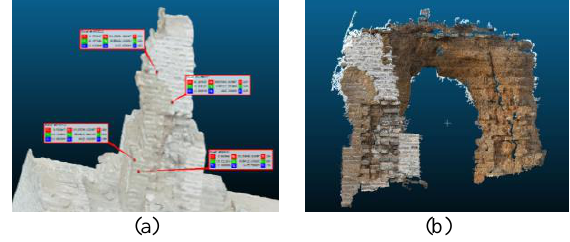
Figure 6. (a) The selected common points for the initial registration; (b) the registration results using SICP algorithm